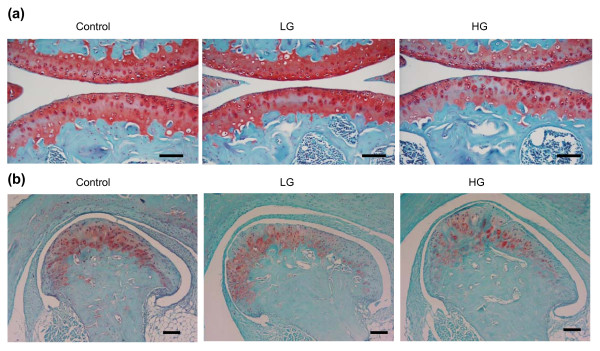
Increased osteoarthritic changes in high-fat-fed high gainer mice. (a) Representative histological images of knee joints showing increased proteoglycan depletion in high gainer (HG) mice as indicated by a loss of the red safranin-O staining. Scale bar = 100 μm. (b) Representative histological images of temporomandibular joints in control, low gainer (LG) and HG mice. There is a nonsignificant trend (P = 0.10) for increased loss of safranin-O staining in LG mice and HG mice. Scale bar = 100 μm.